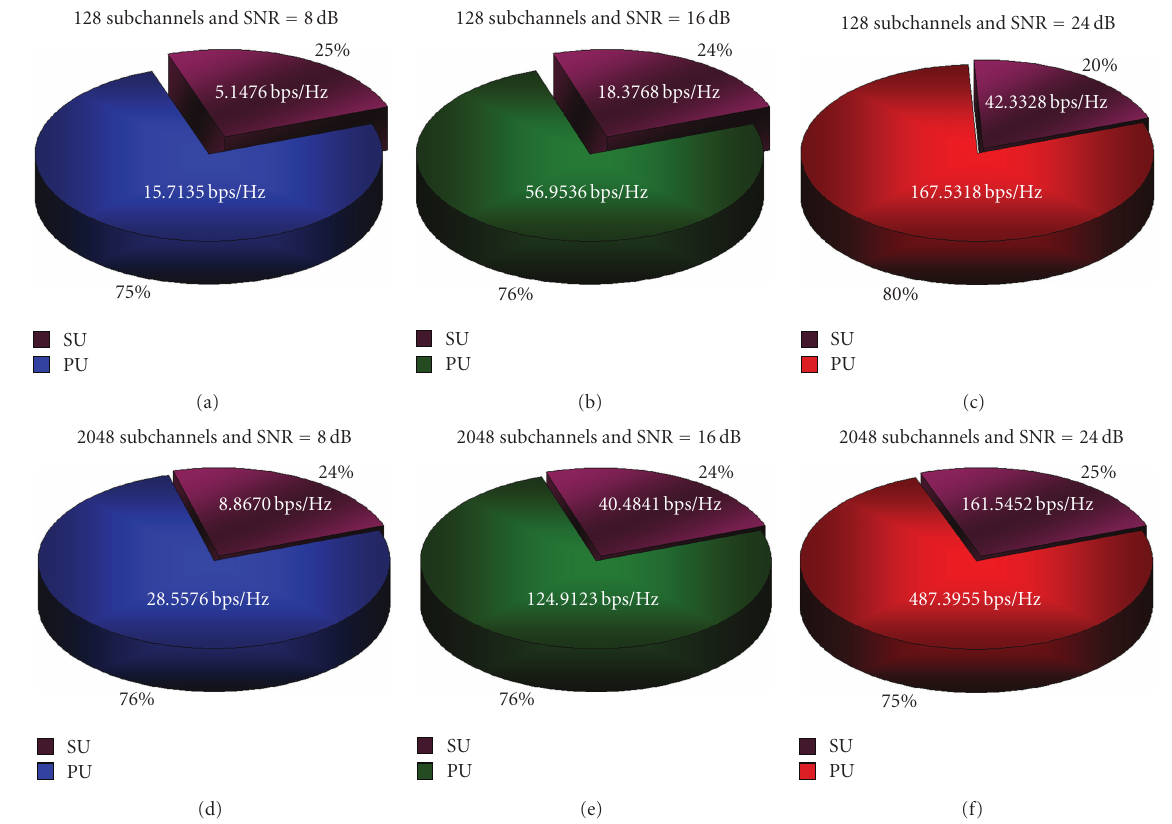
Figure 8: Percentage contribution (PU and SU) in terms of the average capacities (128/2048 subchannels), SNR = 8dB, 16 dB, and 24 dB.